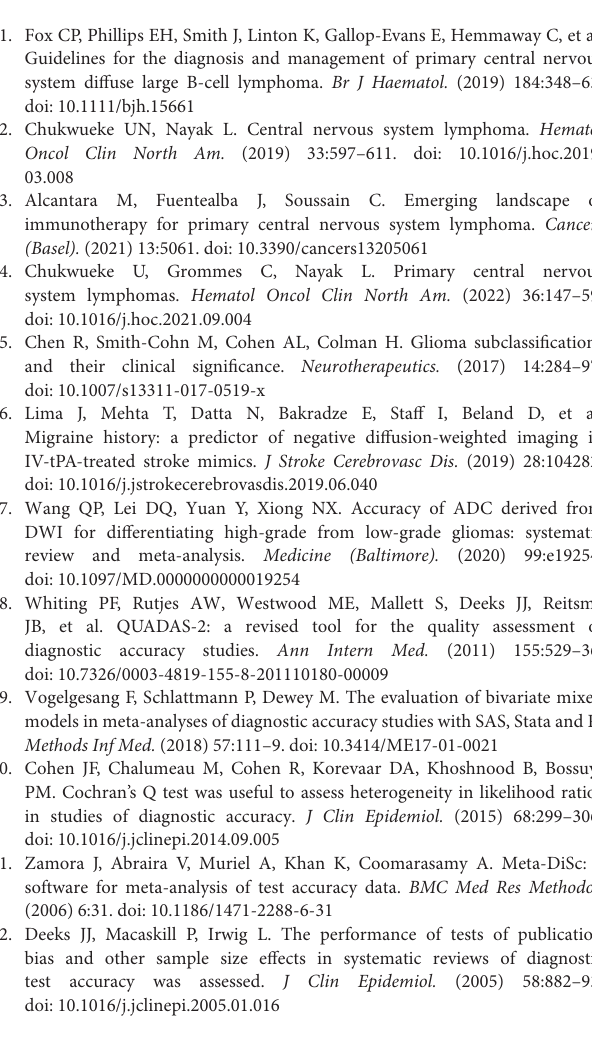
Supplementary Figure 1 | A funnel plot representing the publication